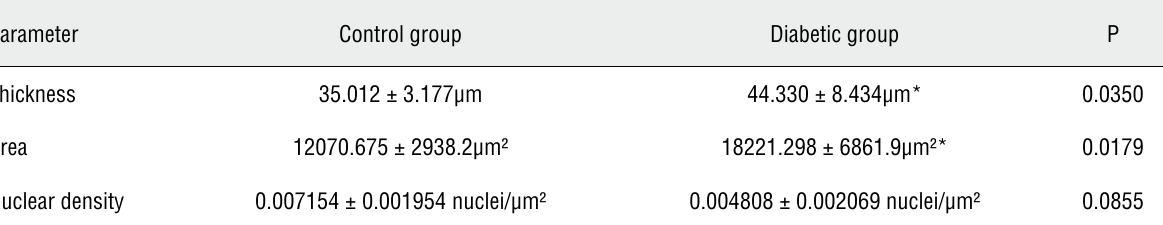
Table 1 - Morphological measurements of the DAP tunica media in control and diabetic rabbits. Data are presented as mean ± SD. Parameter Control group